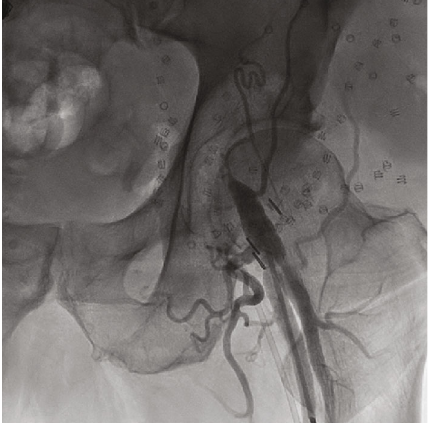
Figure 3: Angiogram showing graft puncture site without